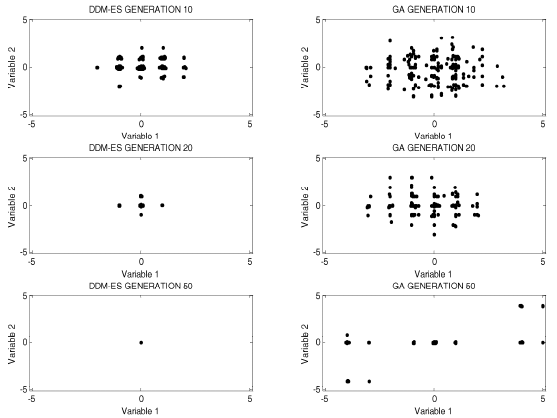
Fig. 6 Populations with Rastrigin’s function with 2 variables